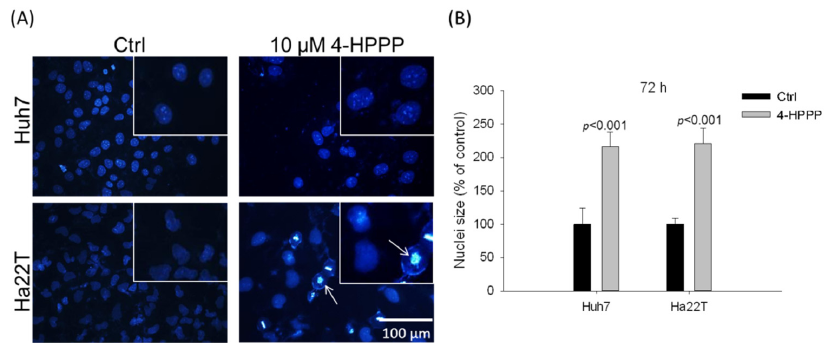
Figure 5. 4-HPPP induces nuclei enlargement of HCC cells. Two HCC cell lines Huh7 and Ha22T were treated with 10 μ M of 4-HPPP for 72 h respectively. Afterward, cells were stained with 0.2 μ g/mL DAPI. ( A ) The representative results of Huh7 and Ha22T cells following 4-HPPP treatment. ( B ) The quantitative analysis of nuclei size of ( A ). White arrows indicate the condensed